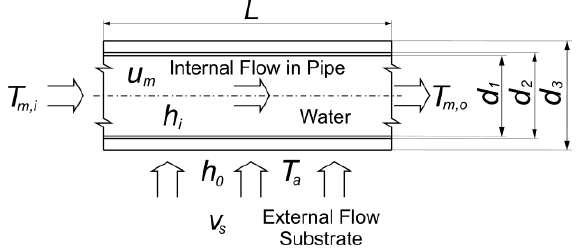
Fig. 2. Schematic diagram of the heat exchanger